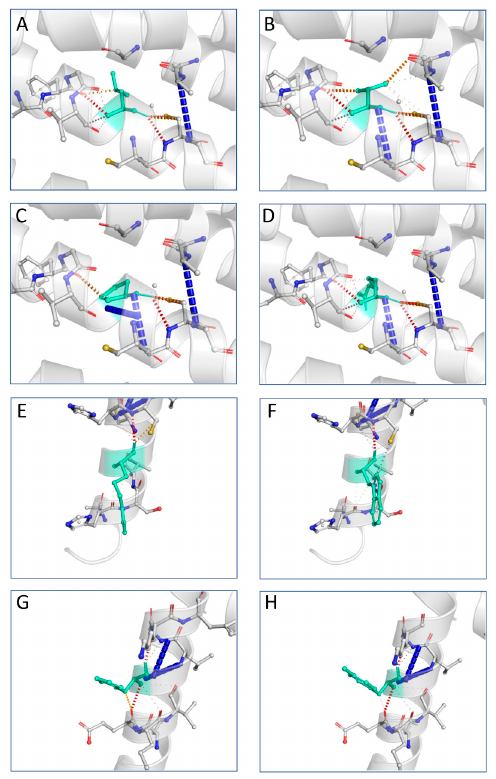
Figure 4. Interatomic interactions for wild-type and mutant PLP1. Both wild-type and mutant residues are colored in light green and depicted as sticks, along with domains participating in any interactions surrounding them. Leucine at position 31 is hydrophobic and highly conserved: ( A ) wild-type residue at position 31; ( B ) L31V (hydrophobic); ( C ) L31P (nonpolar); ( D ) L31R (polar). Arginine at position 137 and histidine at position 140 are polar: ( E ) wild-type residue at position 137; ( F ) R137W (aromatic); ( G ) wild-type residue at position 140; ( H ) H140Y (aromatic). The image is illustrated by DynaMut. A scale of color definition for each type of interaction is provided by software: red depicts hydrogen bonds; slight red depicts water-mediated hydrogen bonds; blue depicts halogen bonds; gold depicts ionic interactions; purple depicts metal complex interactions; light blue depicts aromatic contacts; green depicts hydrophobic contacts; pink depicts carbonyl contacts. The positions of the point mutations are 31, 137 and 140. Abbreviations: L is leucine; P is proline; R is arginine; V is valine; W is tryptophan; H is histidine; Y is tyrosine.